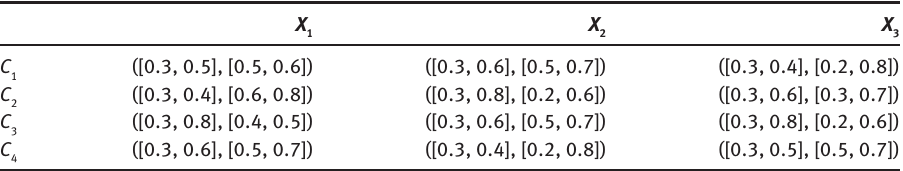
Table 5: Normalized Pythagorean Fuzzy Decision Matrix R 2 .